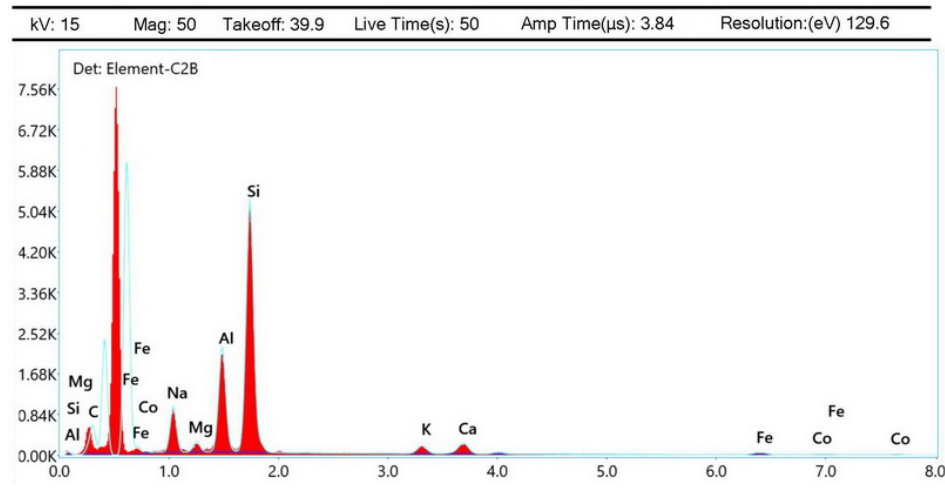
Figure 4. EDAX elemental spectroscopy analysis of Nera sediment sample.